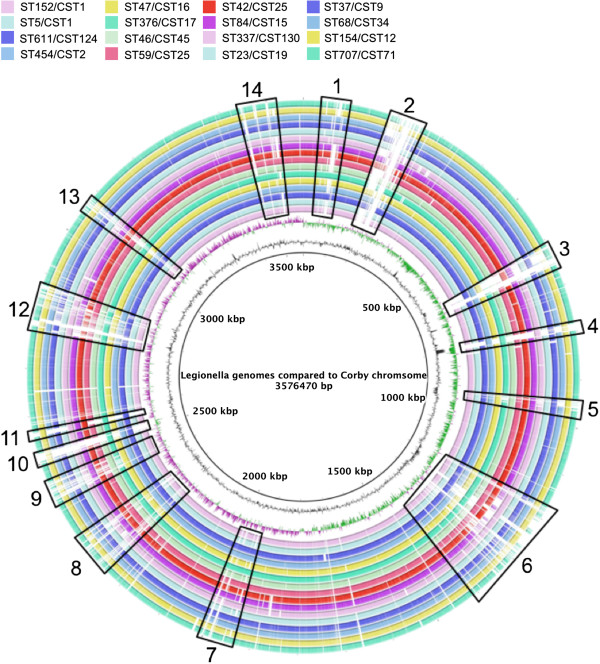
BRIG blast analysis of the Legionella genomes using the genome of Corby as a reference. The strains and figure colours used were from centre to outside ST152 (CST1 mauve), ST5 (CST1 light blue), ST611 (CST124 dark blue), ST454(CST2 medium blue), ST47(CST16 leaf green), ST376 (CST17 dark green), ST46(CST45 light green), ST59 (CST25 pink), ST42(CST14 red), ST84 (CST15 purple), ST337 (CST130 mauve), ST23 (CST19 light blue), ST37 (CST9 dark blue), ST68 (CST34 medium blue), ST154 (CST12 leaf green) and ST707 (CST71 dark green). Regions showing significant variability in genomic content are boxed with black lines and labelled 1–14.